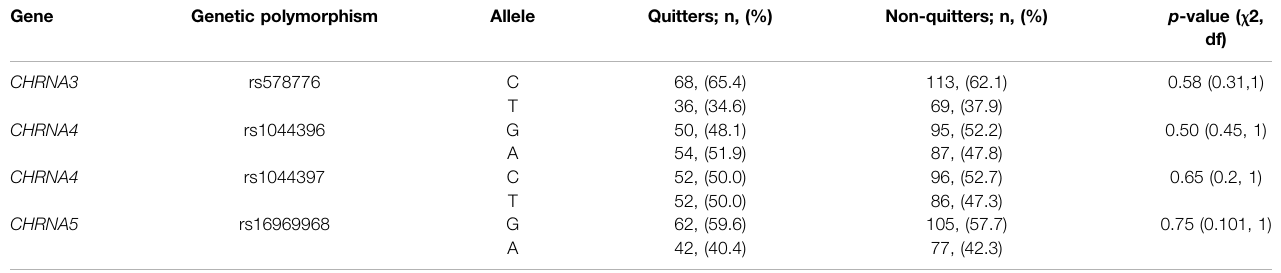
TABLE 4 | Frequencies of genetic variants between quitters and non-quitters. Gene Genetic polymorphism Allele